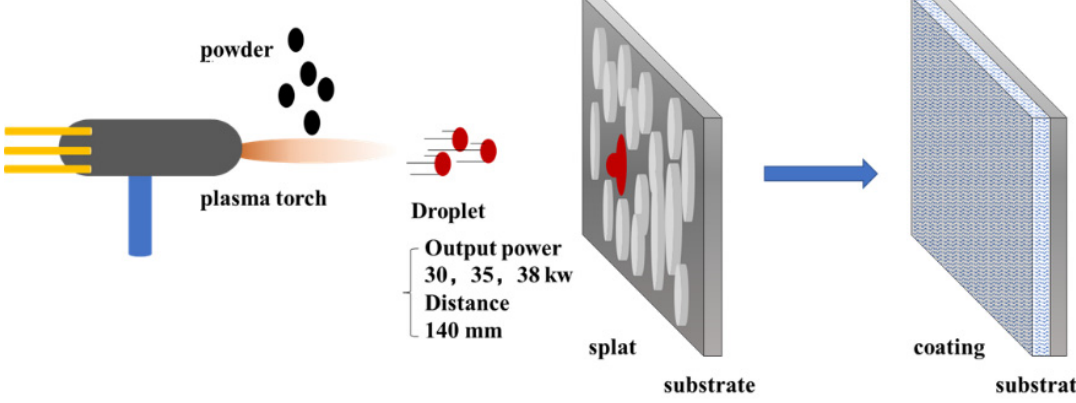
Figure 1. Schematic diagram that illustrates coating process